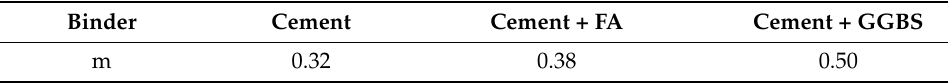
Table 5. The Age Factor of Concrete with Various Admixtures. Binder